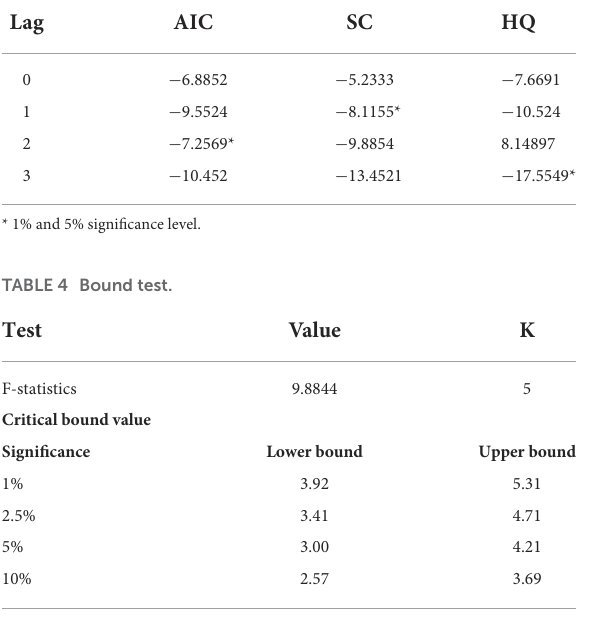
TABLE 3 Lag selection criteria.